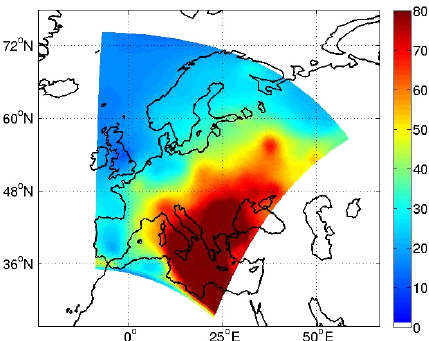
Figure 11. Comparison of cloud liquid-water path (gm − 2 ) with ob- servations from the MODIS sensor onboard the Aqua satellite. The histograms are computed over the entire study area and for the JJA months. The median and standard deviation (in brackets) values are shown for all cases.